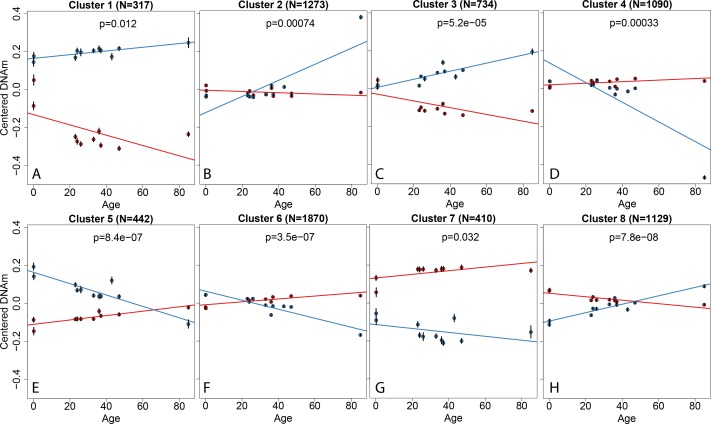
Representative patterns of age-associated changes in DNAm by sampling location.Each panel (A-H) shows mean adjusted expression levels versus age for each of eight clusters of location-specific age-related changes in DNAm levels. Y-axis: mean-centered DNAm levels, x-axis: sample age, p-value represents the statistical interaction between sampling location and age on DNAm levels. N: number of CpGs in the cluster. Vertical lines at each sample indicate +/- 3 times the standard error by cluster.